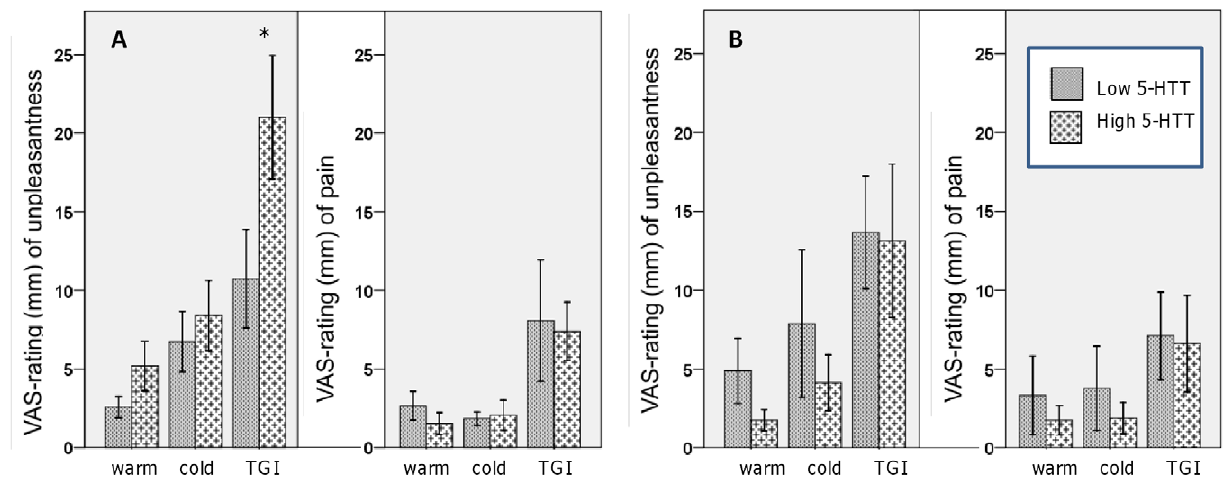
Figure 4. Thermal grill illusion on the basis of tri-allelic 5-HTTLPR genotype and gender. Based on our expectations of gender differences, the genotype groups were further divided into females (panel A) and males (panel B). Females differed significantly in ratings of unpleasantness for the thermal grill, * = significant at p , 0.05.